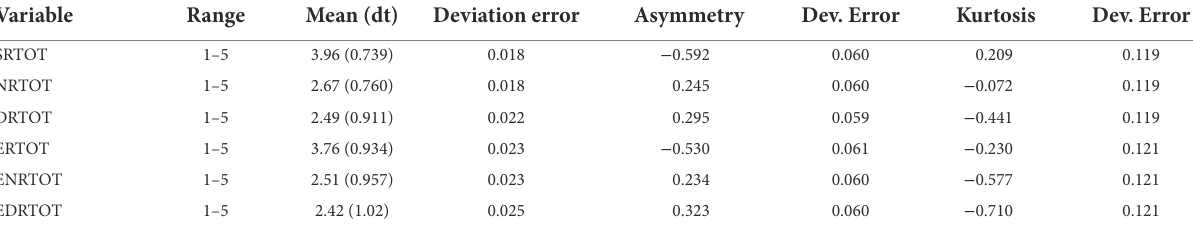
TABLE 4 Values descriptive of the total validation sample ( n = 1,358).